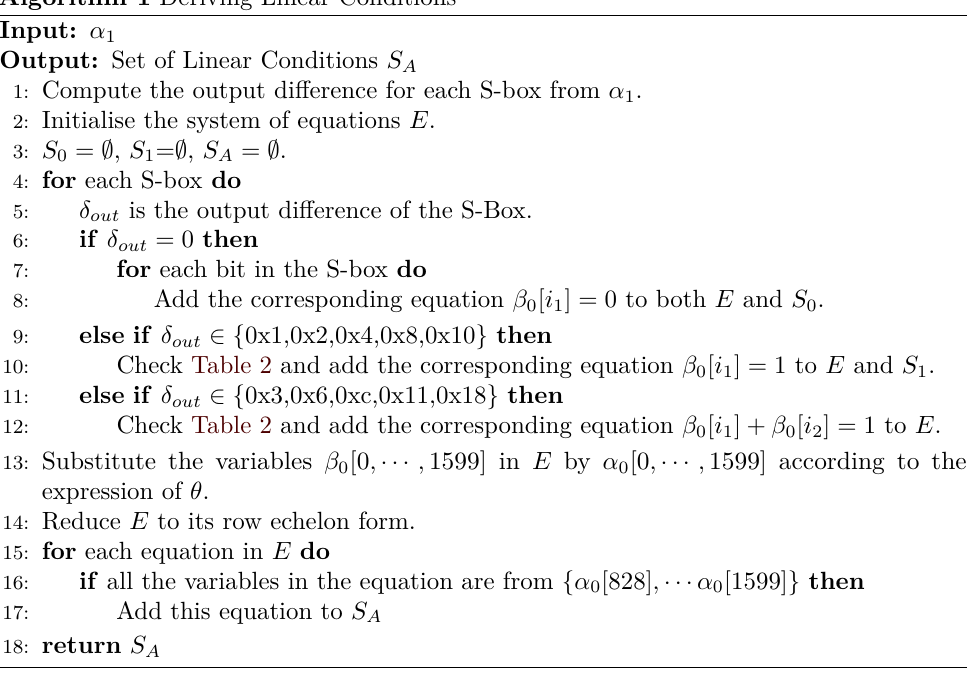
Algorithm 1 Deriving Linear